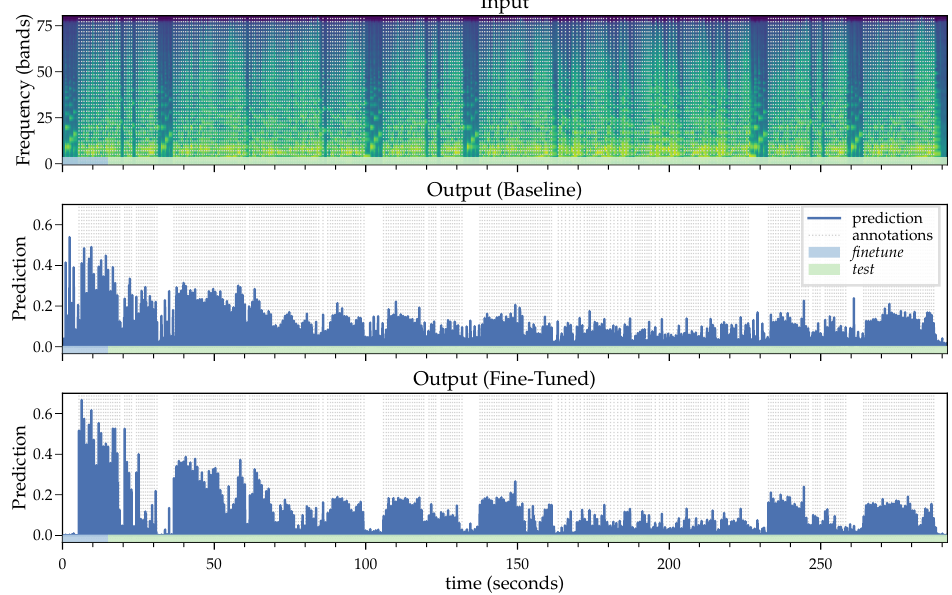
Figure 8. Network input and outputs for the baseline and fine-tuning approaches on Choros № 1 . Finetune region 0–15s (blue) and the test region starting at 15s